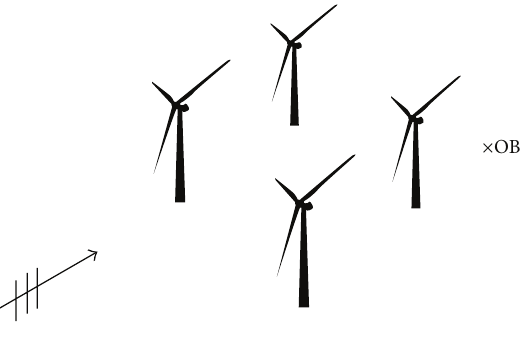
Figure 1: Illustration of the problem